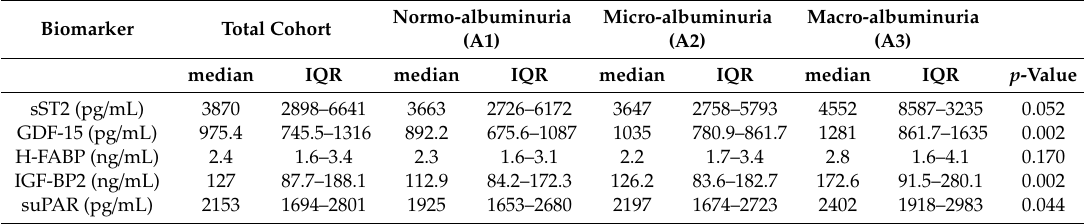
Table 3. Concentrations in patients with normo-albuminuria, micro-albuminuria (UACR 30–300 mg / g, A2), and macro-albuminuria (UACR > 300 mg / g); the p -value represents the statistical di ff erences between the three subgroups of